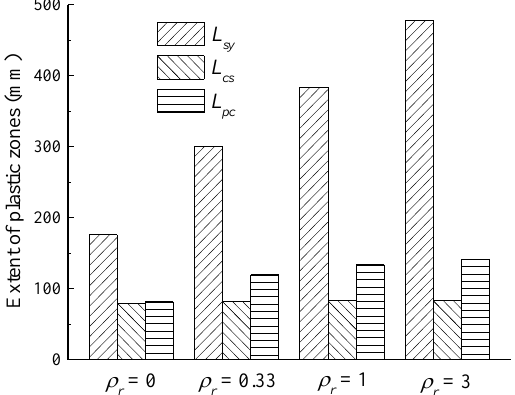
Figure 9. Effect of hybrid reinforcement ratio on plastic hinge length.